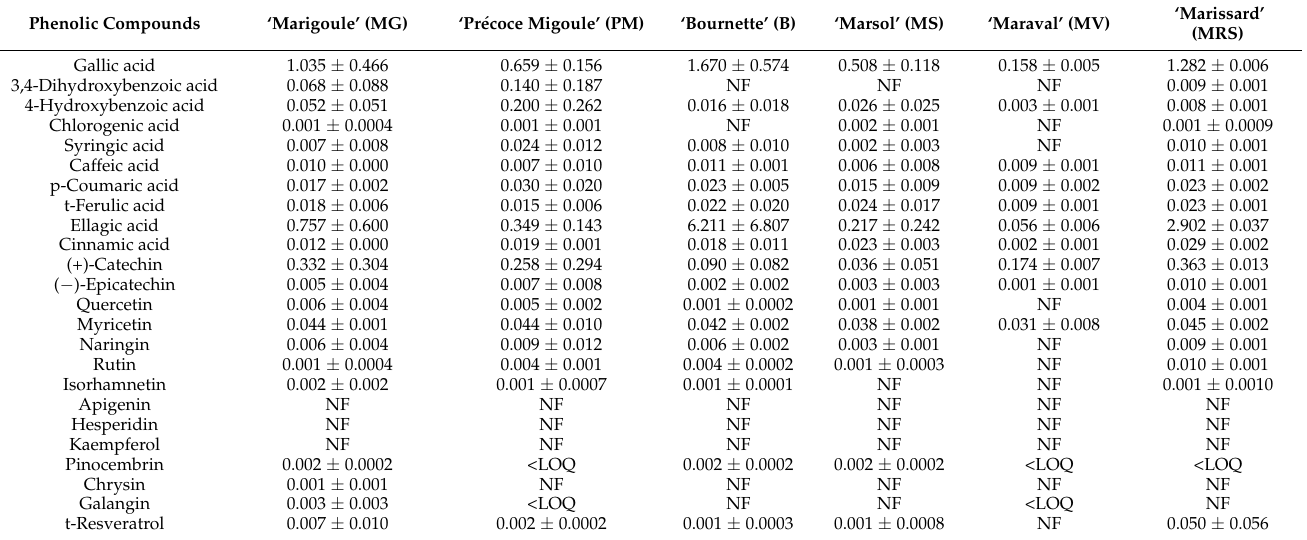
Table 2. The results of the quantitative analysis of phenolic compounds (average values ± standard deviation) in fruits of different sweet chestnut cultivars harvested in 2016 and 2017 (mg/g DW). Phenolic Compounds ‘Marigoule’ (MG) ‘Pr é coce Migoule’ (PM) ‘Bournette’ (B) ‘Marsol’ (MS) ‘Maraval’ (MV) ‘Marissard’ (MRS) Gallic